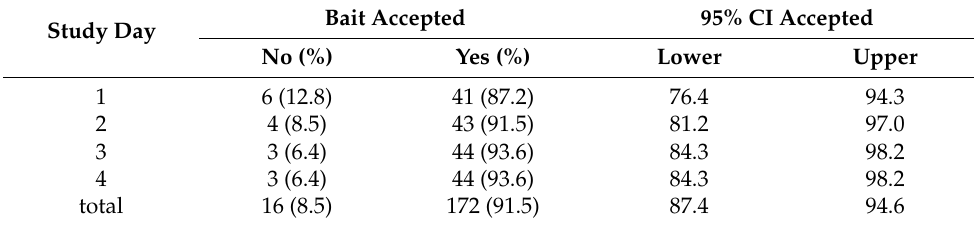
Table 3. Overall bait acceptance according to study